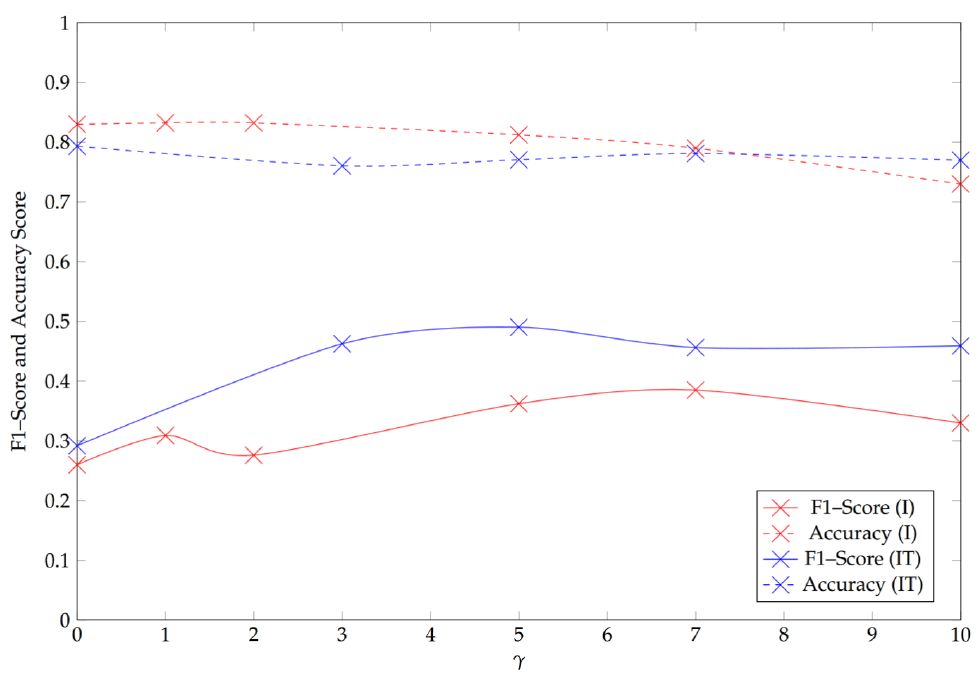
Figure 6. Effects of γ on the accuracy and F1-score metrics. I = only inductive learning approach; IT = mixed inductive–transductive learning